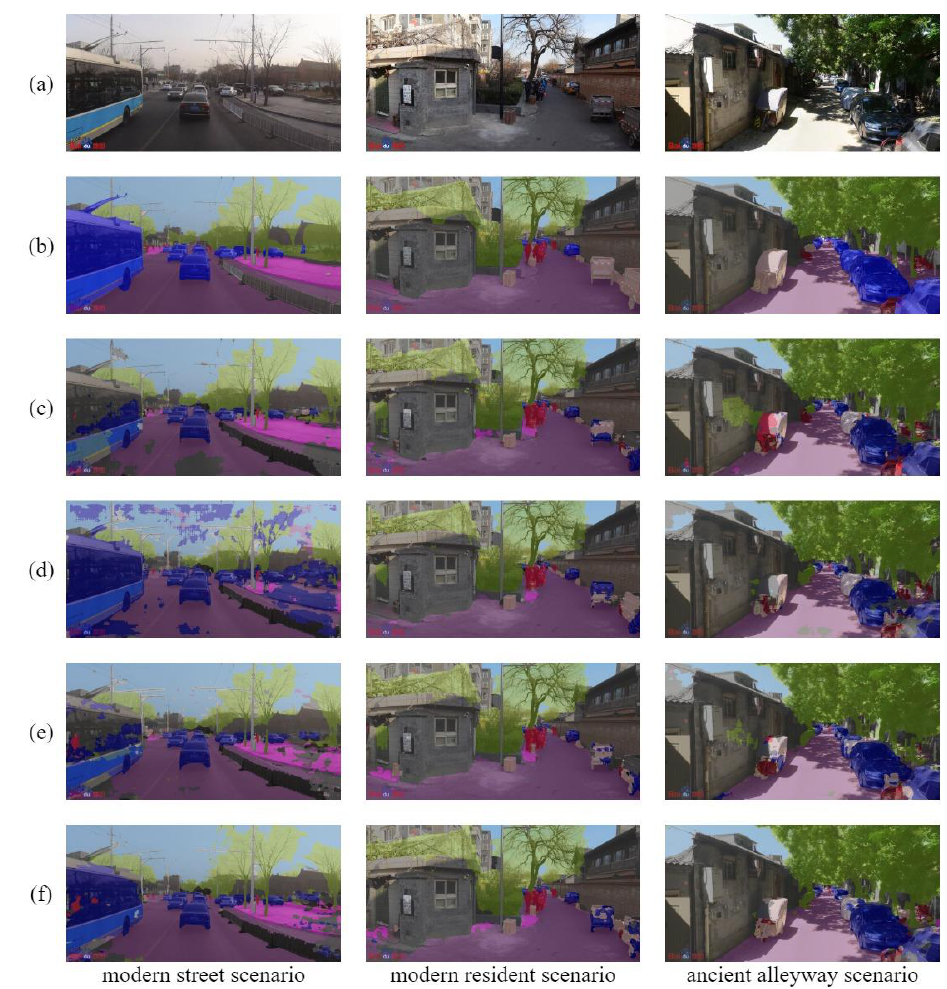
Figure 9. Visual comparison of the modern street scenario, modern residential scenario, and ancient alleyway scenario on HCSV dataset: ( a ) original image; ( b ) ground truth; ( c ) FCN; ( d ) PSANet; ( e ) ANNN; ( f ) our method.